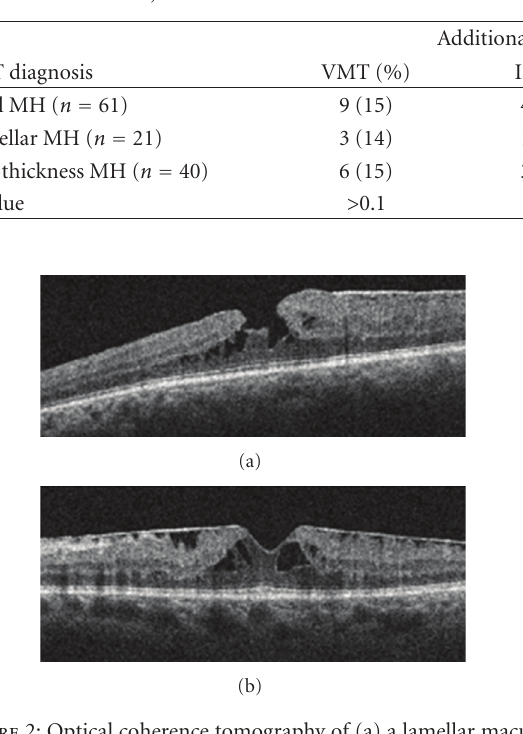
Table 2: Optical coherence tomography (OCT) summary (MH = macular hole; VMT = vitreomacular traction; IRC = intraretinal cysts; SRF = subretinal fluid).